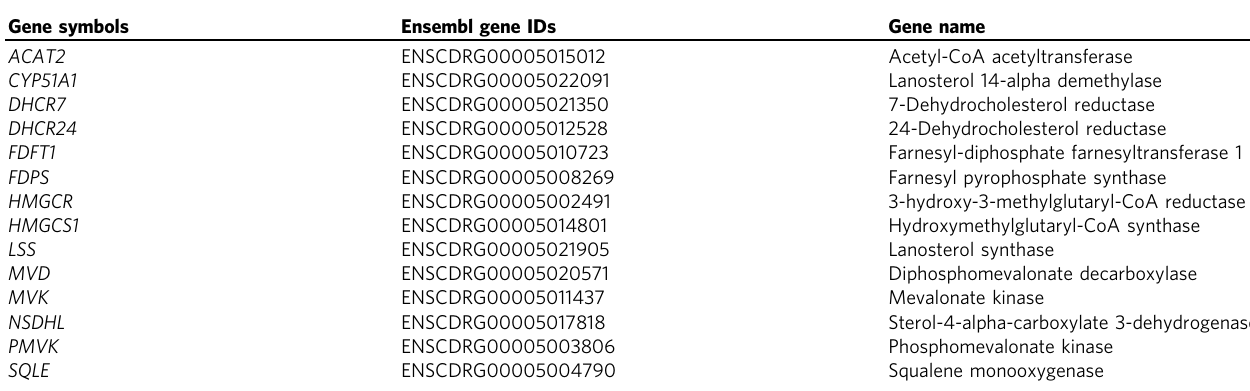
Table 1 Gene symbols, Ensembl ID ’ s and names of the 14 enriched genes encoding enzymes involved in the cholesterol biosynthetic process